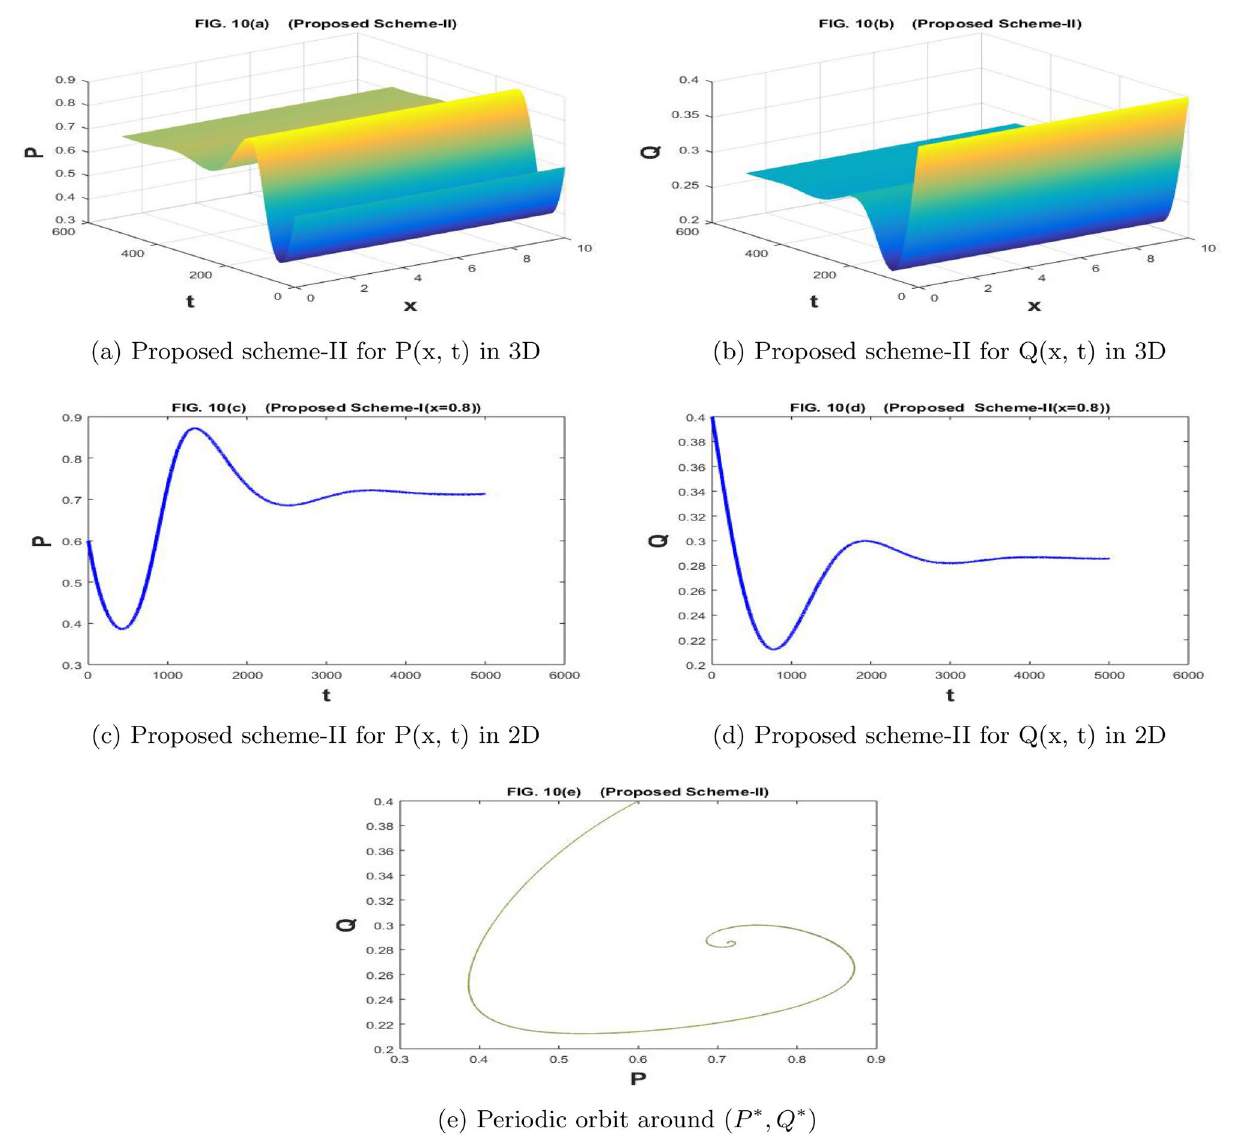
Figure 10. The subfig ( a and c ) and ( b and d ) represents the numerical approximation of P ( x , t ), and Q ( x , t ) respectively by proposed scheme-II. The subfig ( e ) represents the periodic orbit around ( P ∗ , Q ∗ )